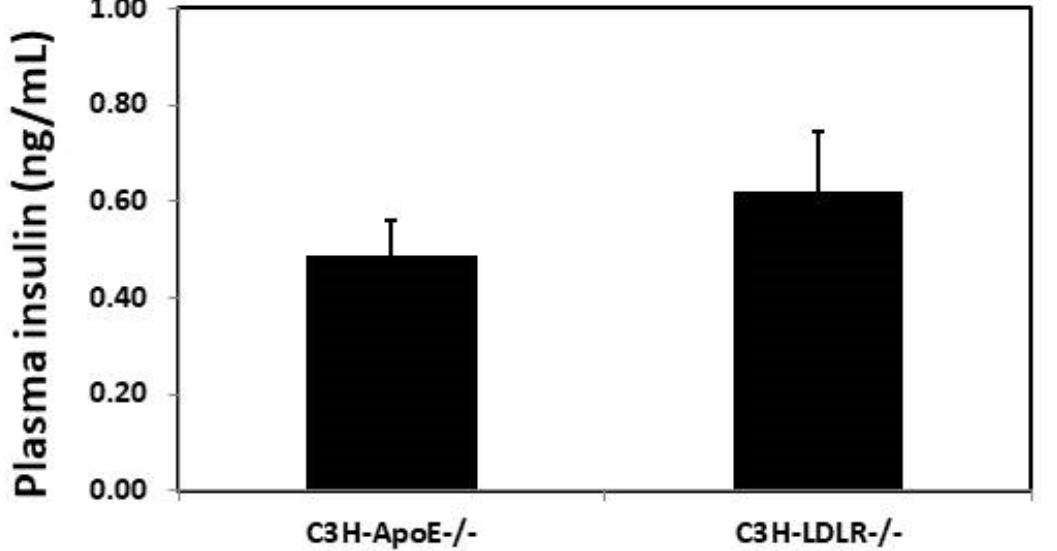
Figure 6. Plasma insulin levels of female C3H- Apoe -/- and C3H- Ldlr -/- mice fed a Western diet. Blood